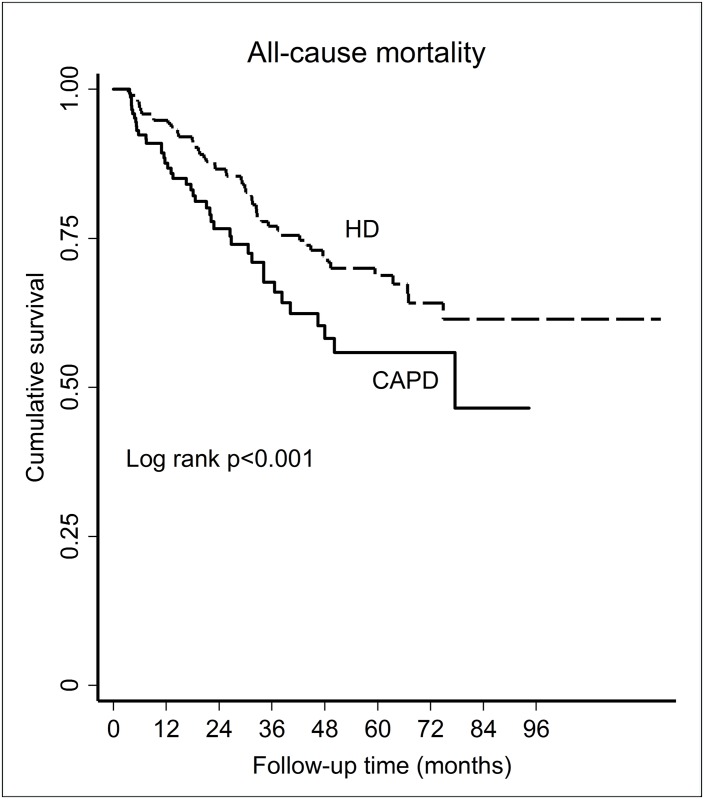
Kaplan-Meier survival curve for all-cause mortality according to dialysis modality.